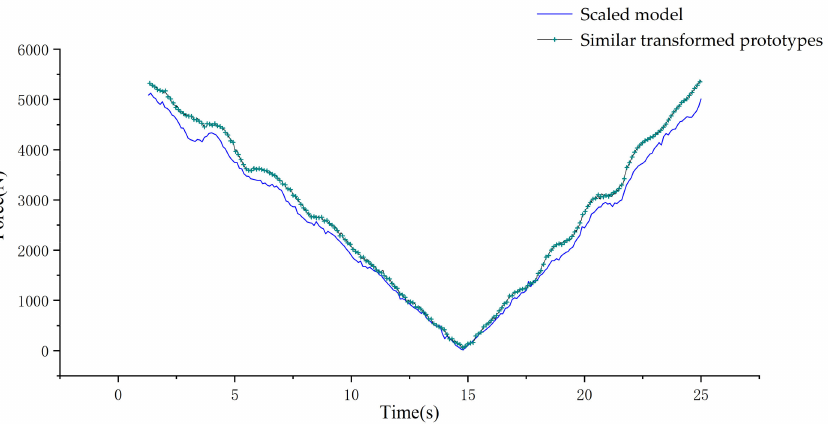
Figure 11. Stress comparison between the lower support part of tensioner support and the hinge of the hydraulic cylinder.